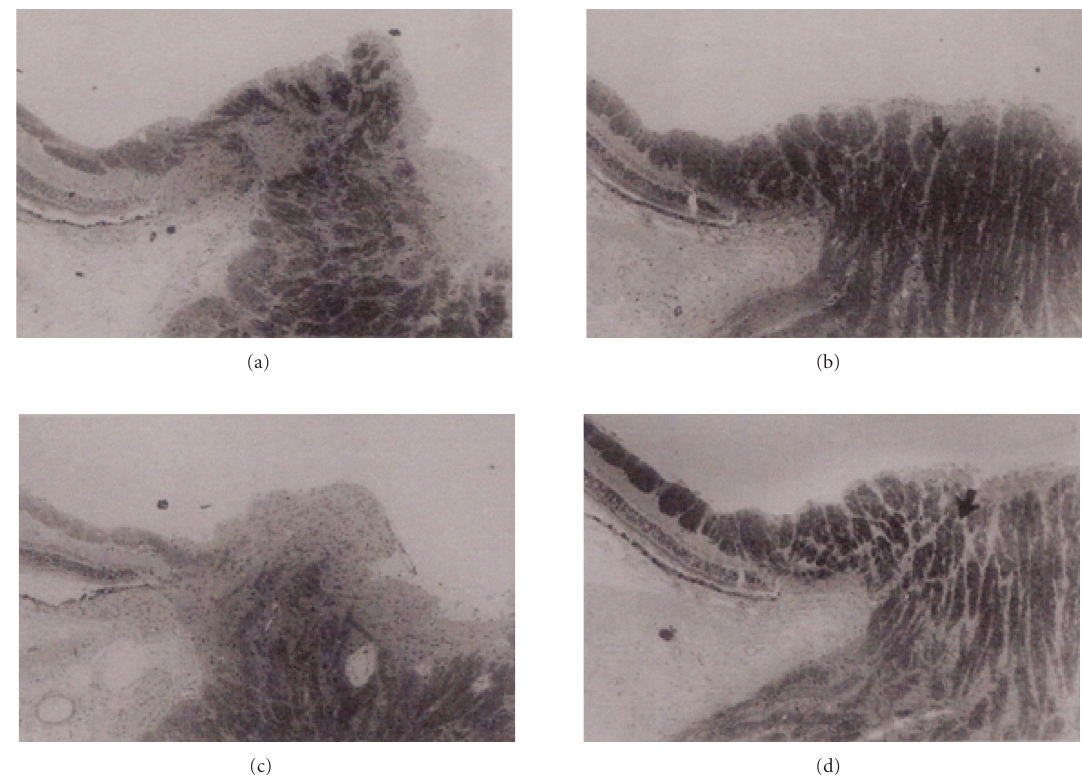
Figure 4: Light microscopic view of two pairs of optic nerves (toluidine blue stain). Optic nerves subjected to endothelin-1 during 8 weeks ((a) and (c)) showed a loss of myelin (dark areas) and a gliosis of the prelaminar portion of the optic nerve compared to the contralateral eyes ((b) and (d)). Arrows point to myelinated nerve fibers in the control eyes ((b) and (d)). Figure adapted from Orgul et al.